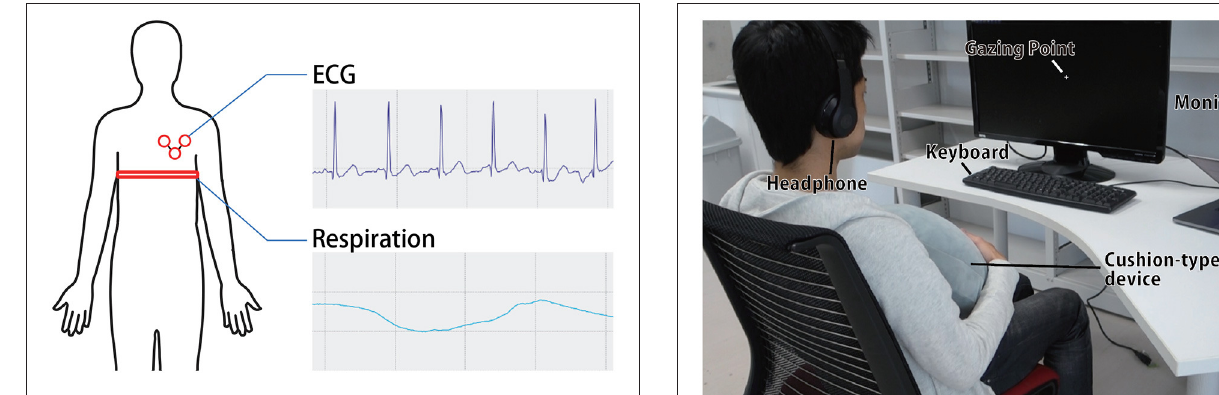
FIGURE 4 | Physiological signal acquisition. The participants were then fitted with an electrocardiographic pad and a breathing measurement band to measure their baseline values of breathing pace, depth, and degree of relaxation.